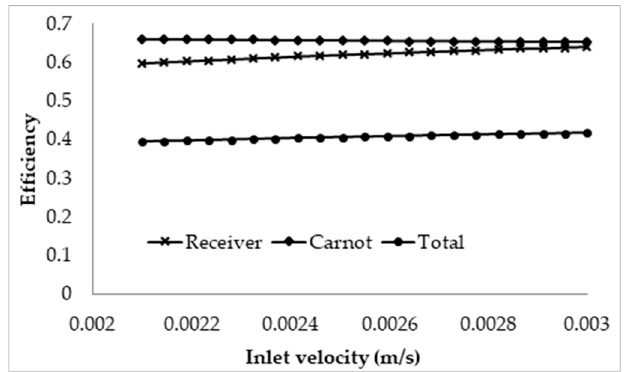
Figure 9. Effect of inlet velocity on the efficiency of the receiver of fixed length of 1 m. Figure 9. E ff ect of inlet velocity on the e ffi ciency of the receiver of fixed length of 1